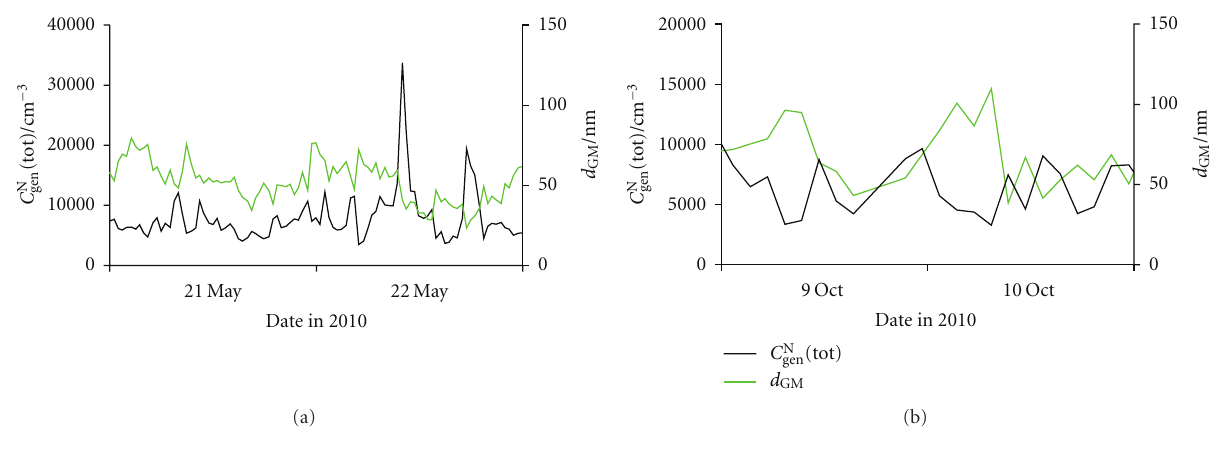
Figure 6: Diurnal variations of the total number concentration of general aerosol ( C N in outdoor air for (a) May 21-22 and (b) October 9-10.